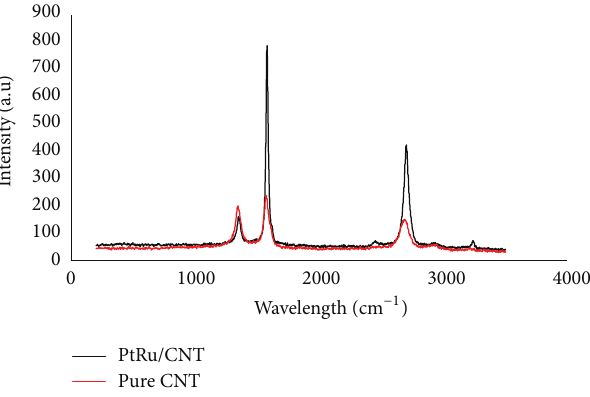
Figure 8: Raman spectra for PtRu/CNT and pure